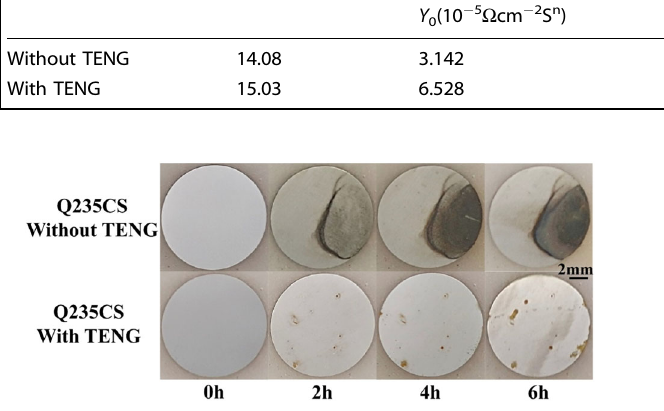
Fig. 6 The digital photographs of Q235 carbon steels. The surface morphology of Q235 carbon steels immersed in 3.5 wt% NaCl solution for 2 h, 4 h and 6 h, separately, connected without and with the S-TENG.